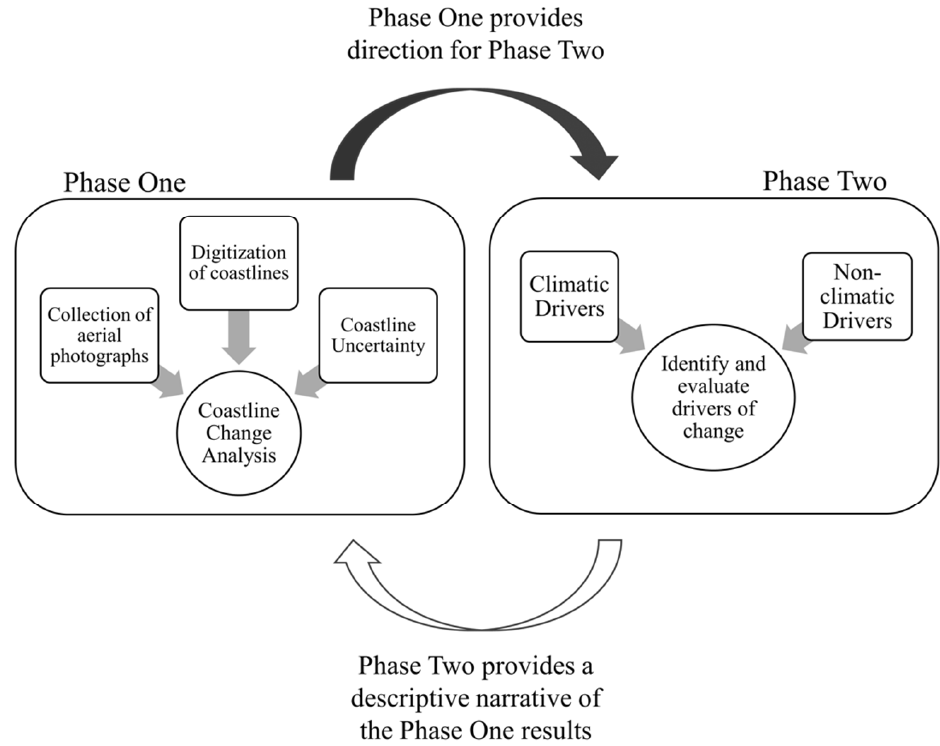
Figure 2. A summary diagraph of the coastal vulnerability methodological approach being pre- sented.